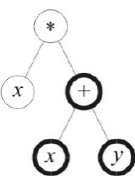
Figure 3. Random computer program as mathematical expression x ( x + y )